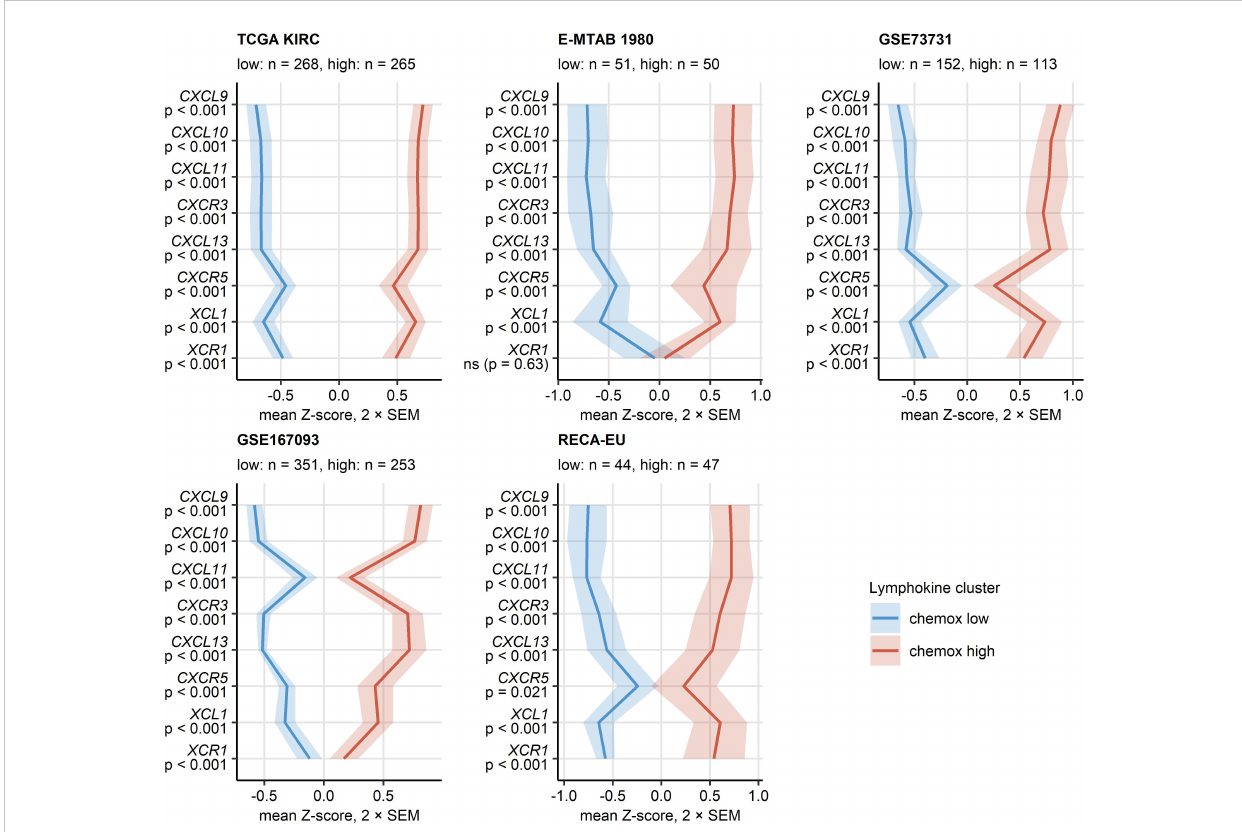
FIGURE 4 Expression of CXCL9/10/11, CXCL13, XCL1 and their cognate receptors in the two chemokine clusters. Chemokine clusters of RCC samples were de fi ned in the TCGA KIRC training cohort in respect to normalized log 2 -transformed expression of CXCL9/10/11, CXCR3, CXCL13, XCL1 and XCR1 by the PAM/cosine distance algorithm. Prediction of cluster assignment in the E-MTAB 1980, GSE73731, GSE167093, RECA-EU, CM 010, CM 025 everolimus and CM 025 nivolumab (CM 025 NIVO) was done with the inverse distance-weighted 15-nearest neighbor classi fi er. log 2 transformed expression of the clustering genes was compared between the chemokine (chemox) high and low cluster by false discovery rate (FDR) corrected two-tailed T test in the TCGA KIRC, E-MTAB 1980, GSE73731, GSE167093, RECA-EU collectives. Mean normalized expression values are visualized as thick lines, tinted regions represent two standard errors of the mean (SEM). P values are shown in the Y axis. Numbers of cancer samples assigned to the clusters are displayed in the plot